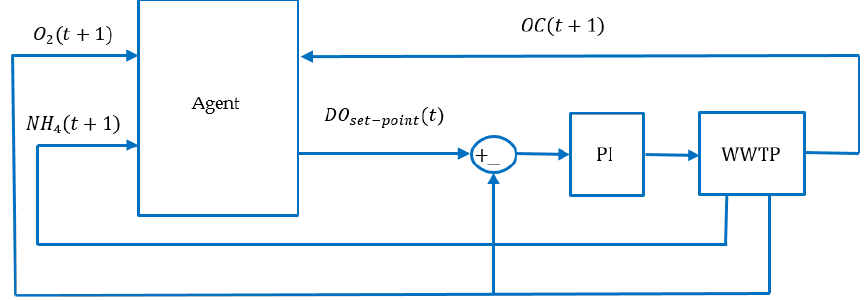
Figure 6. Control loop to autonomously set the DO set-point using the model-free RL agent.